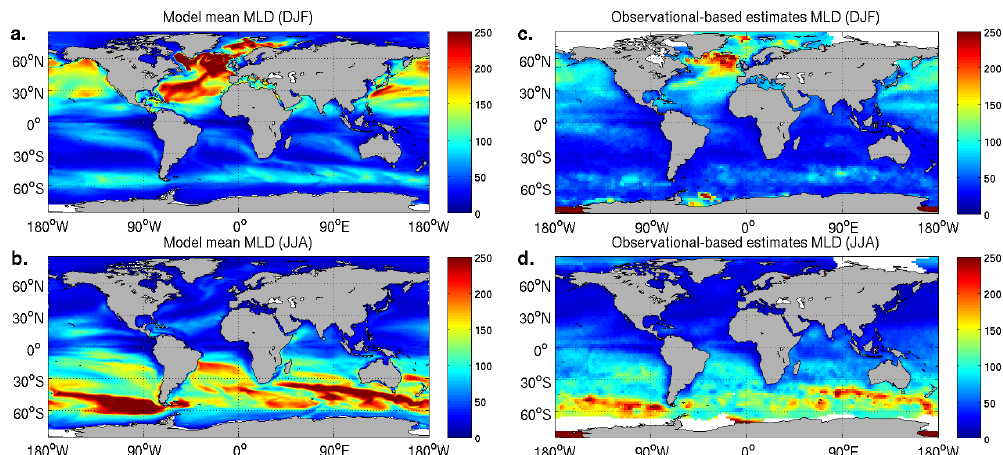
Fig. 5. Map of mean Mixed Layer Depth (MLD) from the model (left) and observational-based estimates (right) for boreal winter (December- January-February) and summer (June-July-August) periods. The model results are computed over the 1991–2000 period from the historical simulation, whereas the observations are adopted from de Boyer Mont´egut et al.